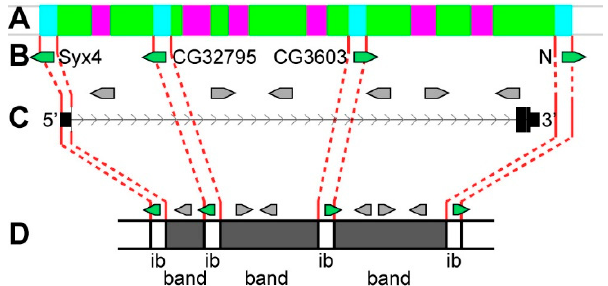
Figure 23. The scheme of the four bands and four interbands formation from the gene material with alternative promoters and three introns composed of late replicated chromatin; grey arrows represent shorter genes located within the introns of the predominant long “main” gene. (A) the four chromatin-state model [39]; (B) moderate level housekeeping genes Syx4 , CG32795 , CG3603 , N ; (C) exons and introns of the kirre gene; and, (D) polytene chromosome bands and interbands (ib) structure comprising “main”, short development, and housekeeping genes.